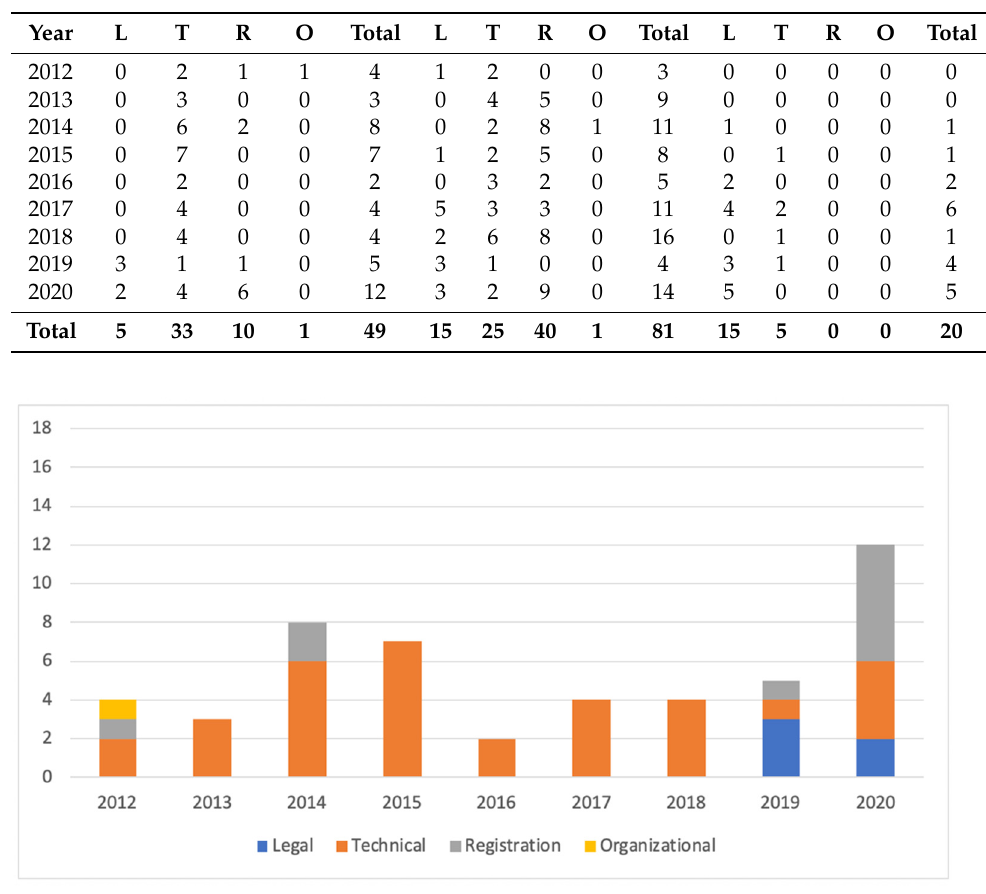
Figure 6. Distribution of visualization sub-topics.